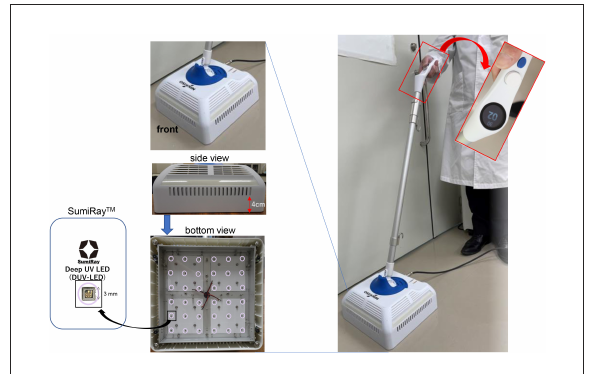
FIGURE1 Picture of newly developed DUV-LED-equipped